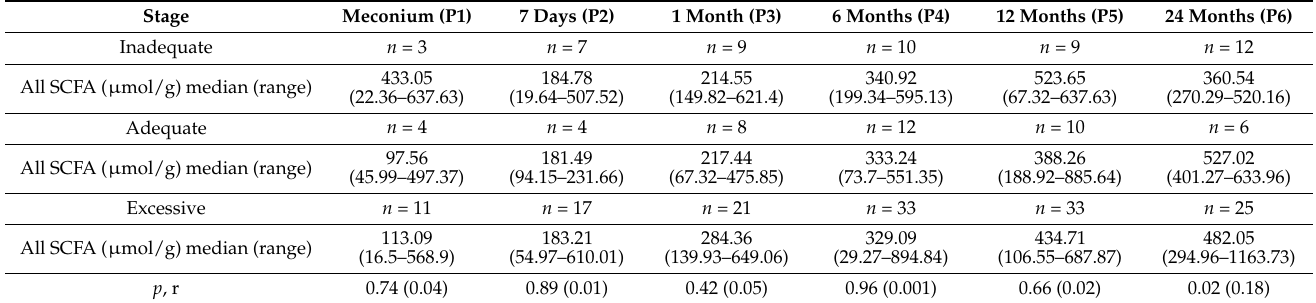
Table 8. Effect of weight gain during pregnancy on all SCFA concentrations.